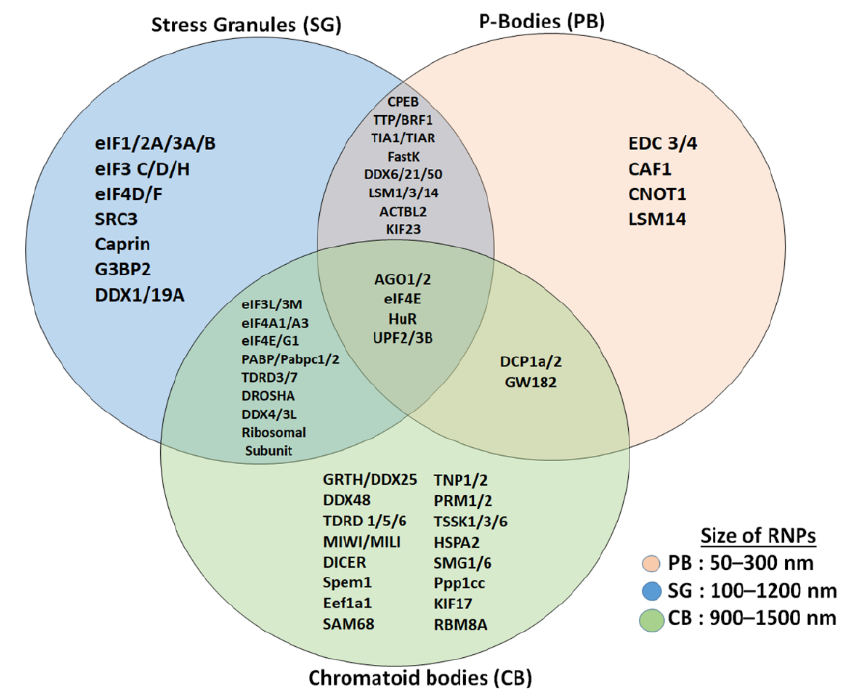
Figure 2. Comparison of proteins (mRNA decay and translation machinery) present in CBs with stress granules and P-bodies. Stress granules and CBs share several initiation factors and translation initiation assembly proteins, while P-bodies and CBs share few of the proteins. CBs are more related to stress granules than to P-bodies and CBs are bigger in size compared to stress granules and P-bodies.